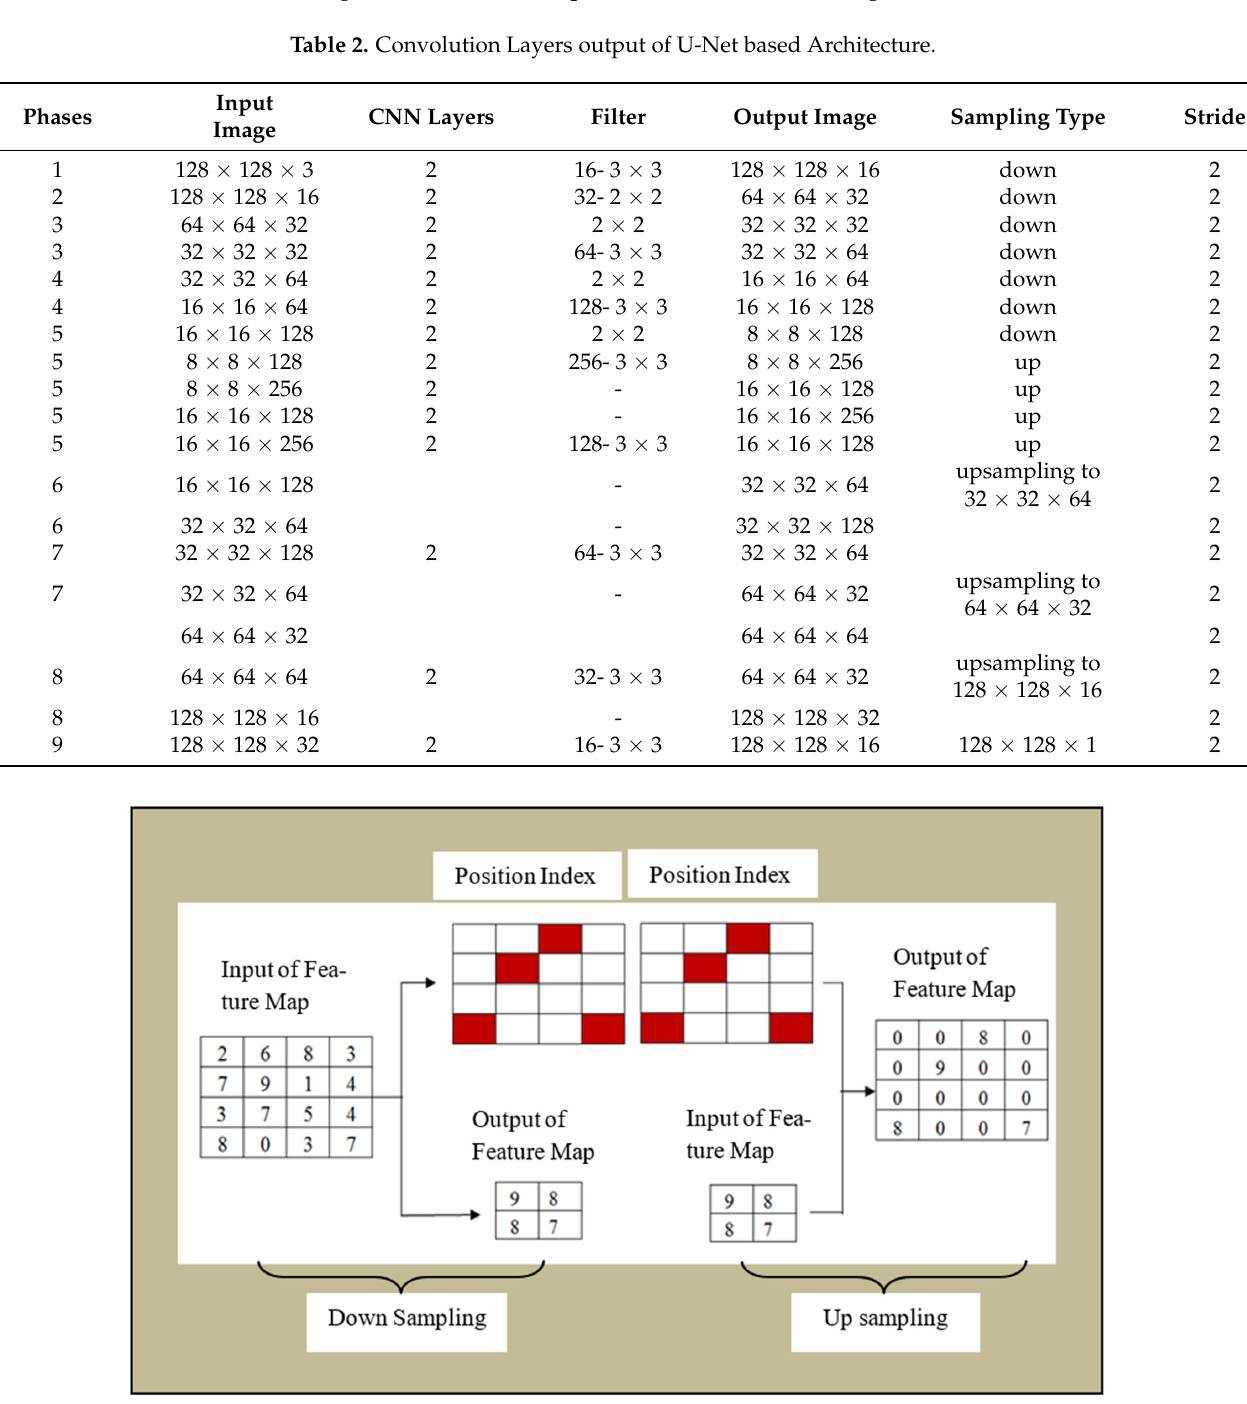
Figure 4. Max-pooling Structure of U-Net/Alex-Net-based Architecture. The maximum value is extracted at every stride and the remaining are deselected. After max-pooling, the dimension of the matrix is calculated by Equation (2). D = Dimension of pooling layer; FS = Filter Size; S = Strides After max-pooling, we applied the activation function. The activation function will